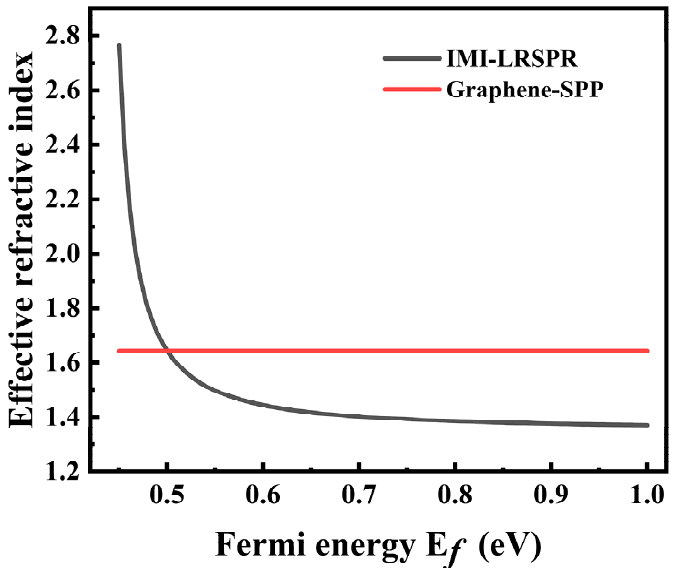
Figure 4. Effective refractive index of graphene-SPP and IMI-LRSPR as a function of E f of DSM.